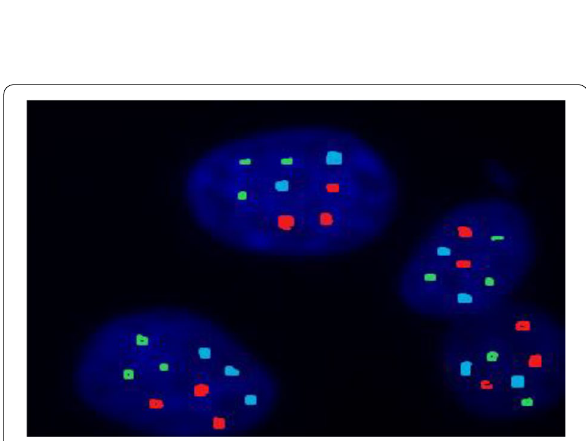
Fig. 3 Interphase FISH using Vysis LSI D5S23, D5S721/CEP 9/CEP 15 FISH Probe showing abnormal cells containing hyperdiploidy of chromosome 5 (three green signals), and chromosome 15 (three red signals)